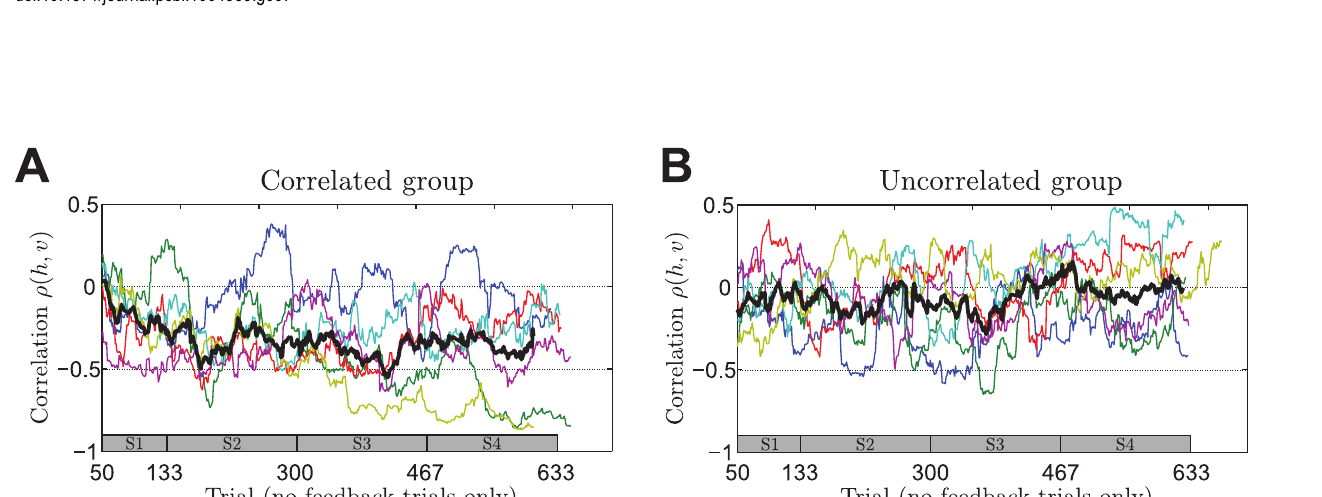
Fig 8. Adaptation of correlation between the vertical and horizontal terminal hand position measured in no-feedback trials. Correlation values are determined in a sliding window of 50 trials across all four sessions. A Correlated group. B Uncorrelated group. For the analysis only no-feedback trials were taken out from the pooled data across all sessions. Thin colored lines indicate individual participants and can vary in length since the exact number of relevant trials could fluctuate due to the probabilistic generation of trials. The thick black line shows the median over participants — taking only into account trials where data from all participants exists. The bar at the bottom of the figure indicates the corresponding session (on average).